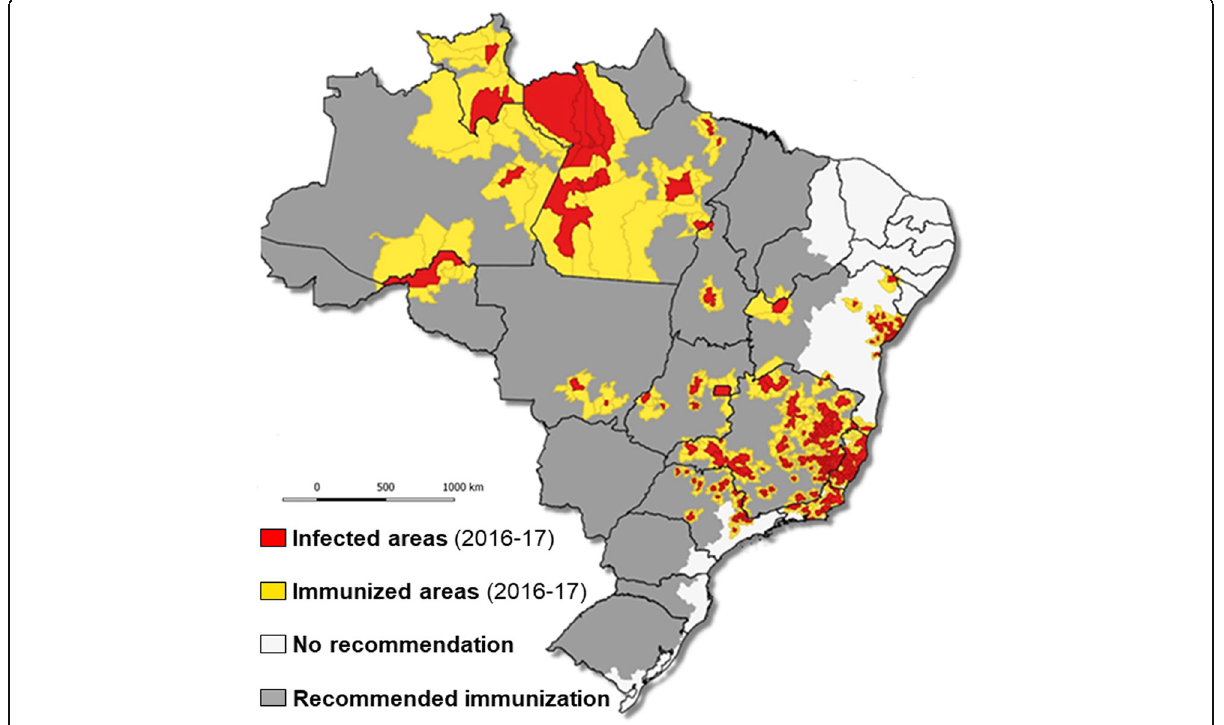
Fig. 6 Municipalities with human cases and non-human primates: infected and immunized areas, Brazil, 2016/2017